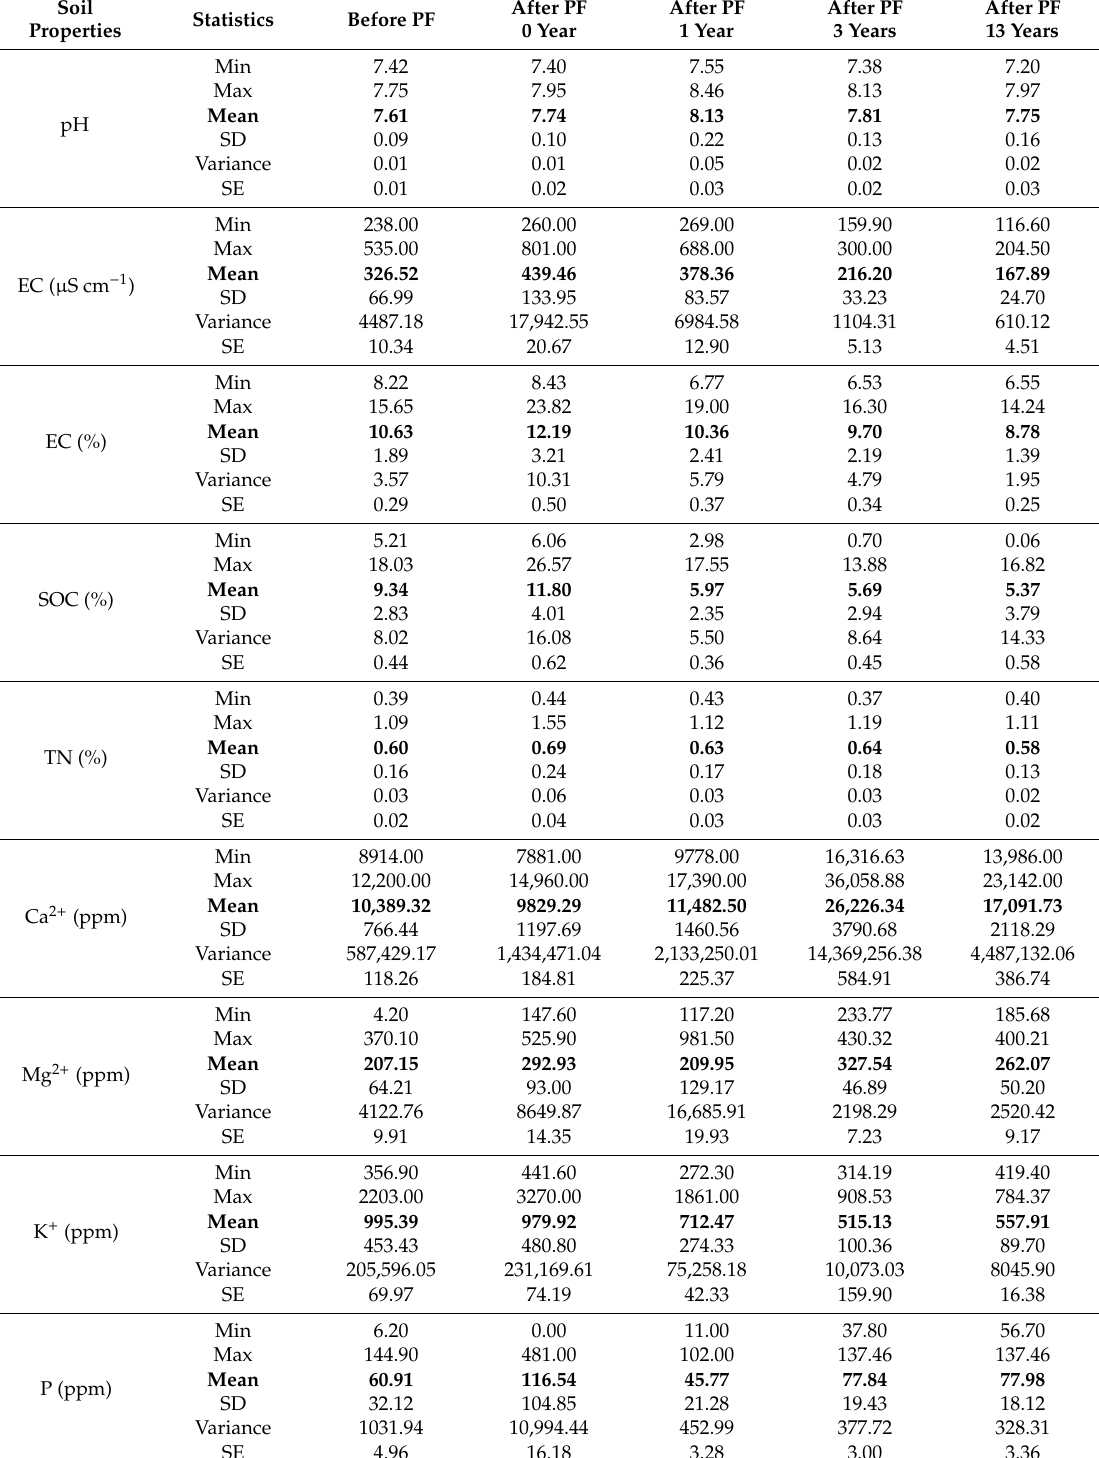
Table 1. Minimum, maximum, mean (bold), standard deviation (SD), variance, and standard error (SE) values before the prescribed fire (PF), after PF, one year after PF, 3 years after PF, and 13 years after PF. Soil